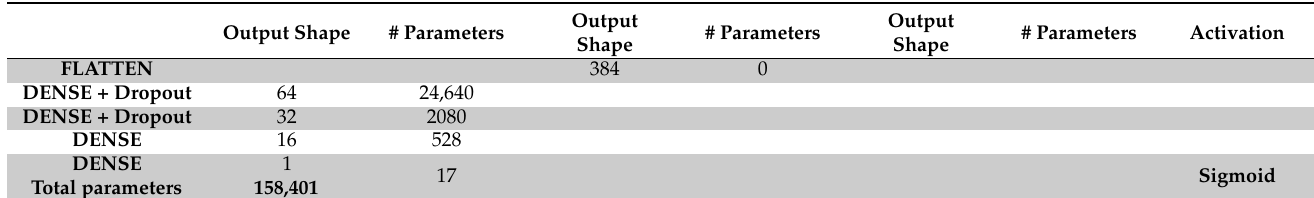
Figure 3. The classification module of the MsRes.